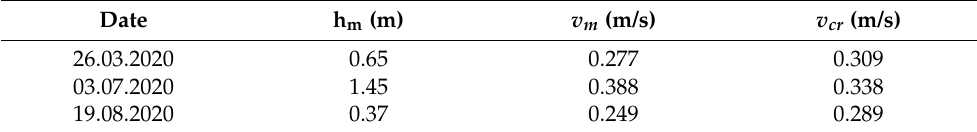
Table 2. Calculated mean and critical velocity in riverbed zone (site M8; v m —mean velocity; v cr — critical depth-averaged velocity; h m —mean water